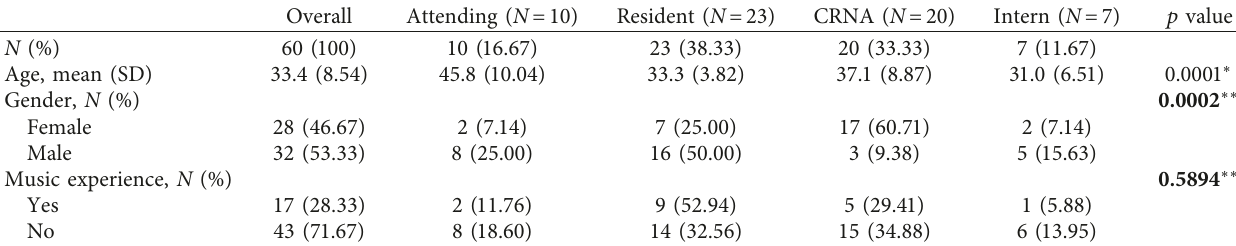
Table 1: Descriptive statistics.